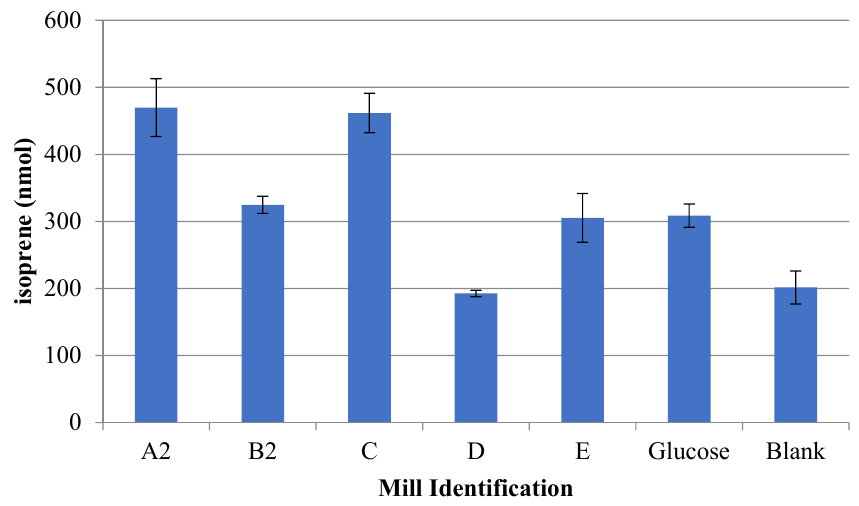
Figure 1. Maximal isoprene yield nmol isoprene in headspace gas. ( ± S.D.) ( n = 3). Table 4. Total glucose concentration of sugar solution from Mills A2, B2, C, D and E, Number hours for consumption of all glucose, Maximal ethanol yield (%, g ethanol / g glucose) and the productivity of